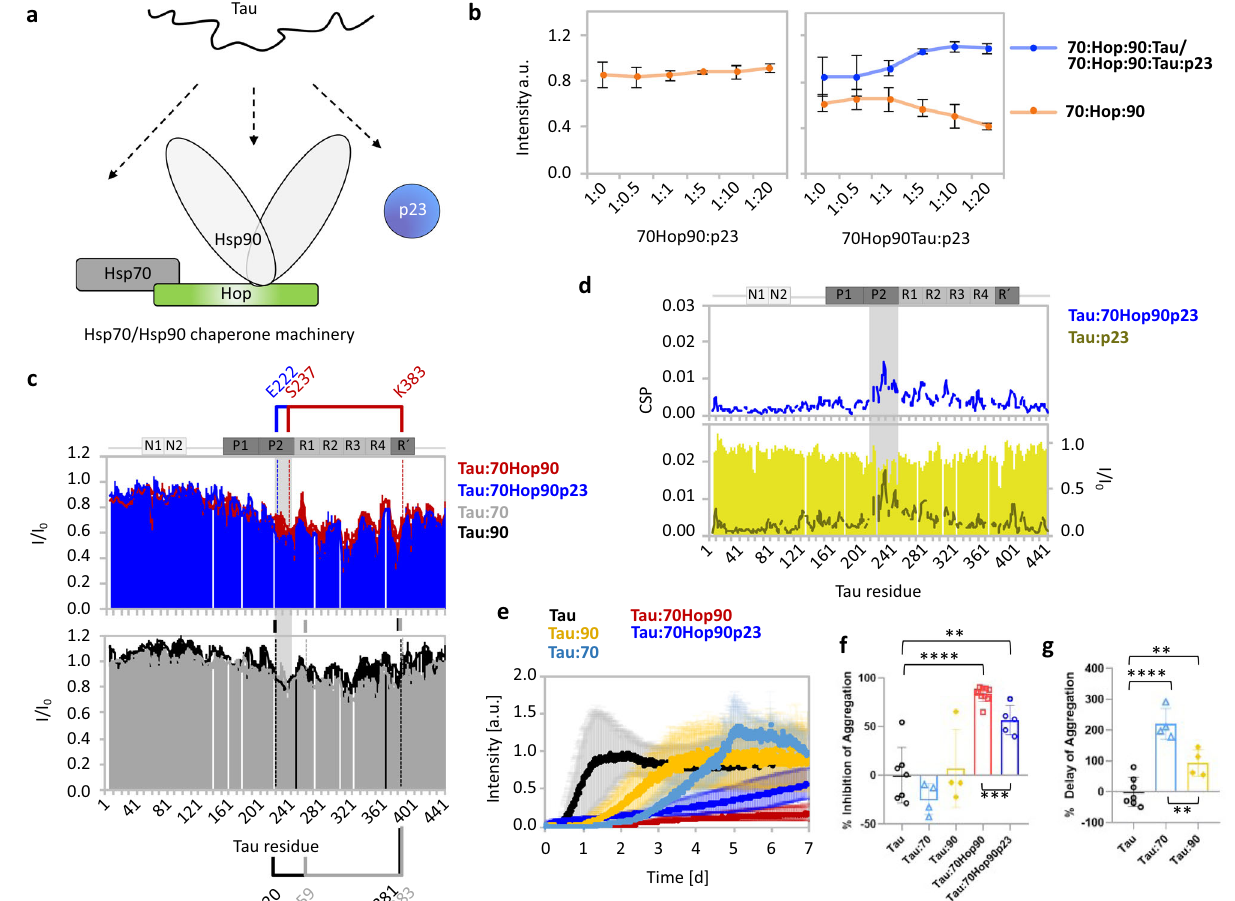
Fig. 2 p23 stabilizes the Hsp70/Hsp90 multichaperone:Tau interaction. a Cartoon representation of Tau interacting with the Hsp70/Hsp90 chaperone machinery and p23. b Quantitative analysis of the band intensities from Supplementary Fig. 2a, b demonstrating the formation of the 5-component Hsp70:Hop:Hsp90:Tau:p23 complex. The 4-component Hsp70:Hop:Hsp90:Tau and 5-component Hsp70:Hop:Hsp90:Tau:p23 complex were analyzed together due to the closely positioned bands. Data are shown as mean ± SD from three independent experiments. c NMR interaction pro fi les of Tau from Supplementary Fig. 2f in the presence of the Hsp70/Hsp90 chaperone machinery with (blue; top) and without p23 (red; top), and upon addition of Hsp70 (gray; bottom) and Hsp90 (black; bottom) only. Results using Tau:chaperone molar ratios of 1:2 are shown for all experiments. The main interaction sites are emphasized in brackets. d Top: chemical shift perturbations of Tau in presence of Hsp70, Hop, Hsp90 and p23. Bottom: NMR interaction pro fi le of Tau in the presence of p23 (tenfold molar excess). e Aggregation assay of Tau alone and in the presence of individual or combined components of the Hsp70/ Hsp90 chaperone machinery using a mole ratio of 1:0.2 (Tau:machinery or Tau:chaperone). For panels e – g , data are presented as mean values ± SD from n independent experiments: n = 7 for Tau, n = 4 for Tau:Hsp70, n = 4 for Tau:Hsp90, n = 10 for Tau:Hsp70:Hop:Hsp90, n = 5 for Tau:Hsp70:Hop:Hsp90:p23. For panels f , g , null hypothesis testing was performed using an unpaired, two-tailed t -test. f Inhibition of Tau aggregation by individual or combined components of the Hsp70/Hsp90 chaperone machinery (* p ≤ 0.033, ** p ≤ 0.0021, *** p ≤ 0.0002, **** p ≤ 0.0001) from panel e (also related to Supplementary Fig. 2g). g Delay of Tau aggregation by Hsp70 or Hsp90 (* p ≤ 0.033, ** p ≤ 0.0021, *** p ≤ 0.0002, **** p ≤ 0.0001) determined from the ThT curves in panel e. The % delay cannot be accurately calculated for Tau:70Hop90/ Tau:70Hop90p23 because the ThT curves for these systems are almost fl at, i.e. not sigmoidal. A lower limit for the % delay in these systems is ~200%, which is the % delay of Tau aggregation in the presence of Hsp70. Source data are provided as a source data fi